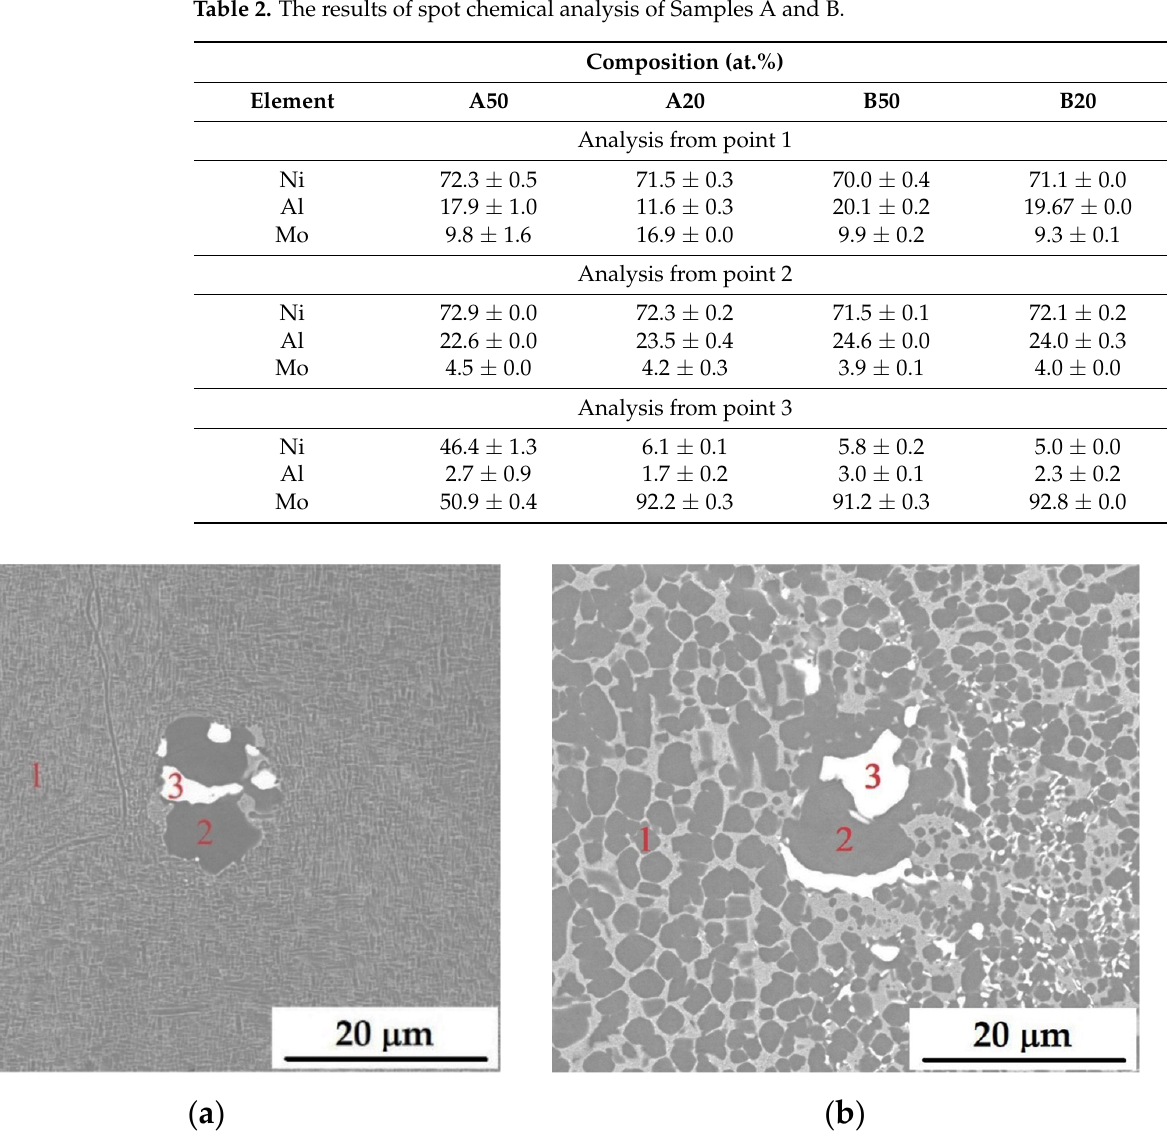
( a ) ( b ) Figure 7. Microstructure of sample B: ( a ) Sample B50 after DS at rate 50 mm/h; ( b ) Sample B20 after DS at rate 20 mm/h; 1—two-phase regions γ / γ′ , 2— γ′ -Ni 3 (Al,Mo) phase, 3—Mo-rich phases.